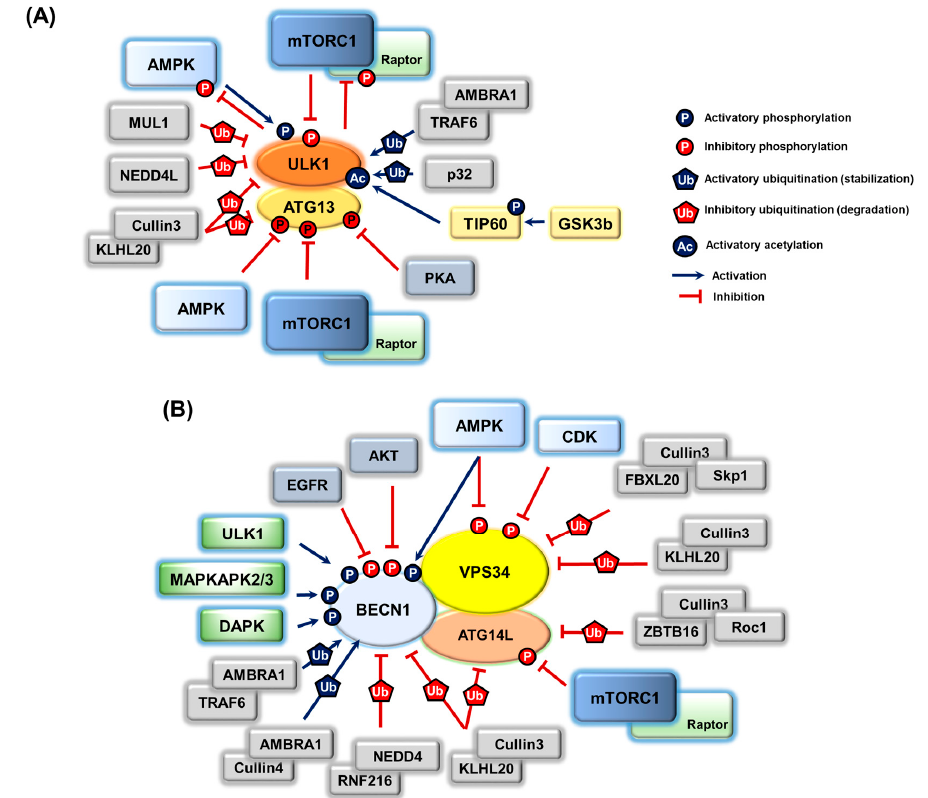
Figure 3. Post-translational modifications and regulations of two key autophagy-initiating kinase complexes, the ULK1 and PIK3C3/VPS34 complex. ( A ) The ULK1 complex is regulated by